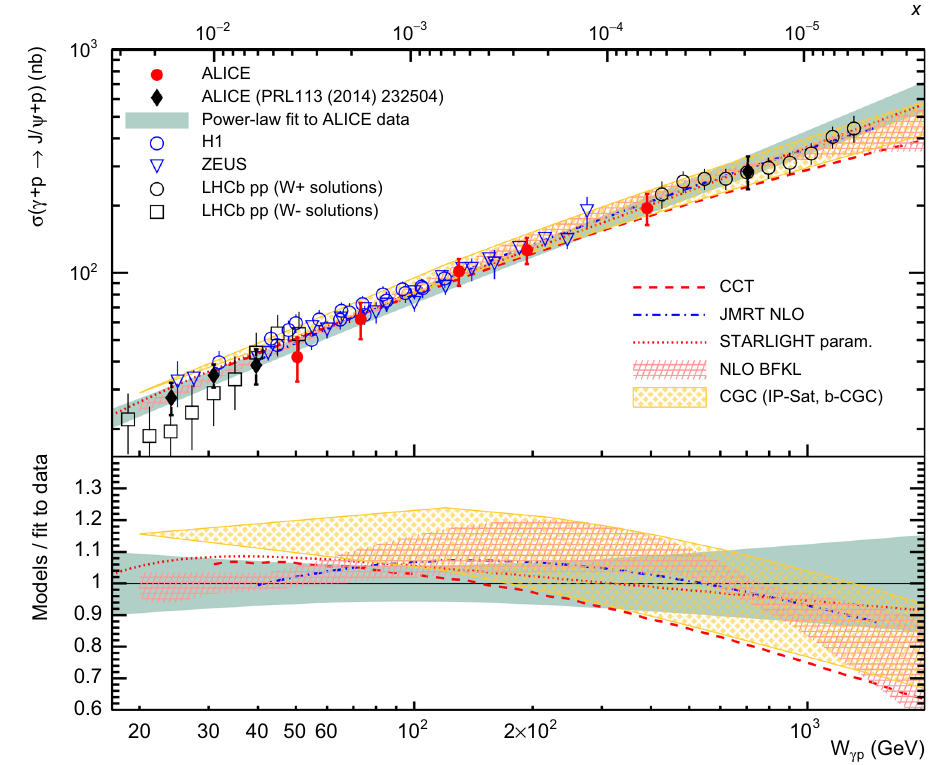
Fig. 3 (Upper panel) ALICE data (red symbols) on exclusive photoproduction of J /ψ off protons as a function of the centre-of-mass energy of the photon–proton system W γ p , obtained in collisions of protons √ = 5 . 02 s and lead nuclei at NN TeV, including results from [19], compared to a power-law fit, to data from HERA [9,11], to the solutions from LHCb [39] and to theoretical models (see text). The uncertainties are the quadratic sum of the statistical and systematic uncertainties. (Lower panel) Ratio of the models shown in the upper panel to the power law fit through the ALICE data points. The Bjorken x value corresponding to W γ p is also displayed on the top of the figure, see text for